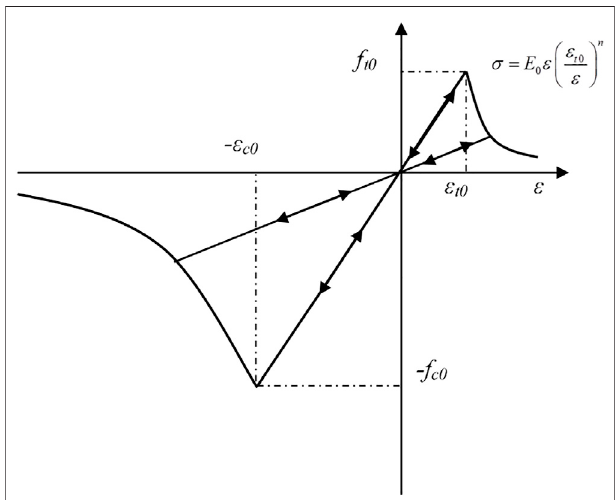
FIGURE 2 | The elastic damage-based constitutive law under uniaxialstress condition (Zhou et al., 2018).